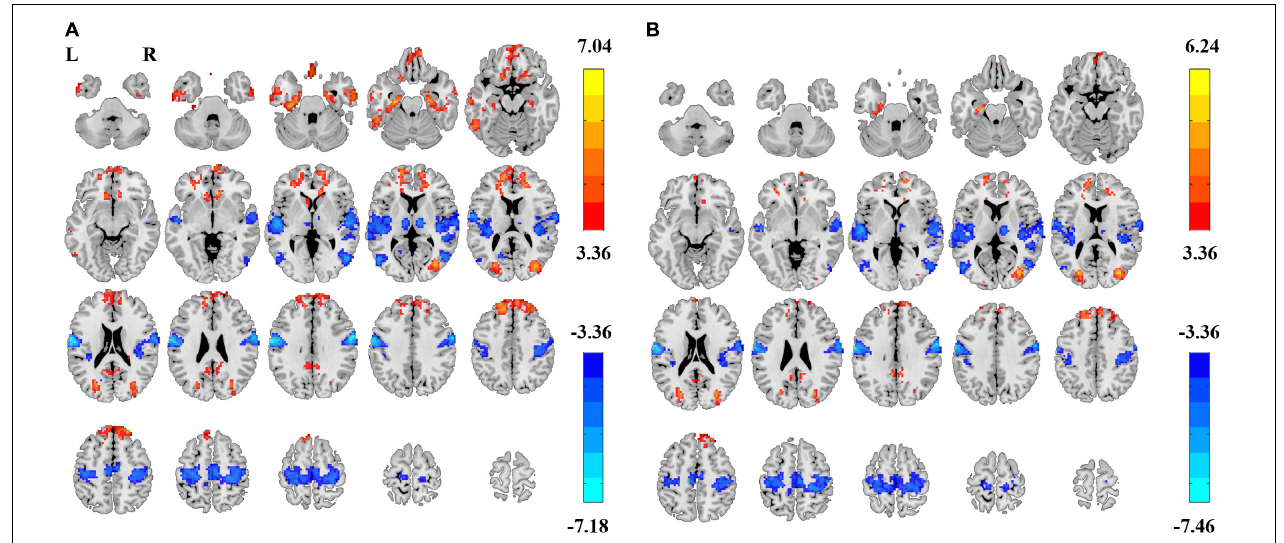
FIGURE 4 | Differences of power spectrum slope (PSS) between EC and EO using group-level Z-transformed coefficient b and power-law slope b’. Significant difference between EC and EO conditions using coefficient b (GRF correction, P corrected < 0.05, |T| > 3.36, cluster size > 40 voxels) (A) and using power-law slope b’ (GRF correction, P corrected < 0.05, |T| > 3.36, cluster size > 50 voxels) (B) . L, left; R, right.